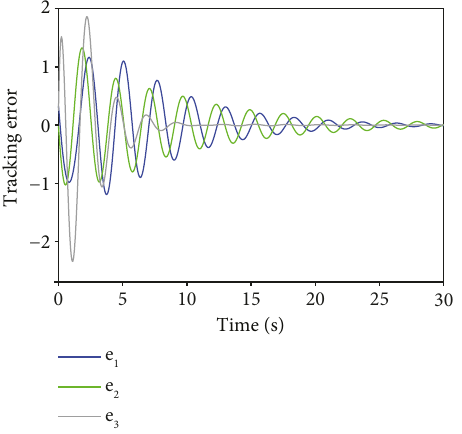
− y = y i = 1,2,3 by output- i 0 i